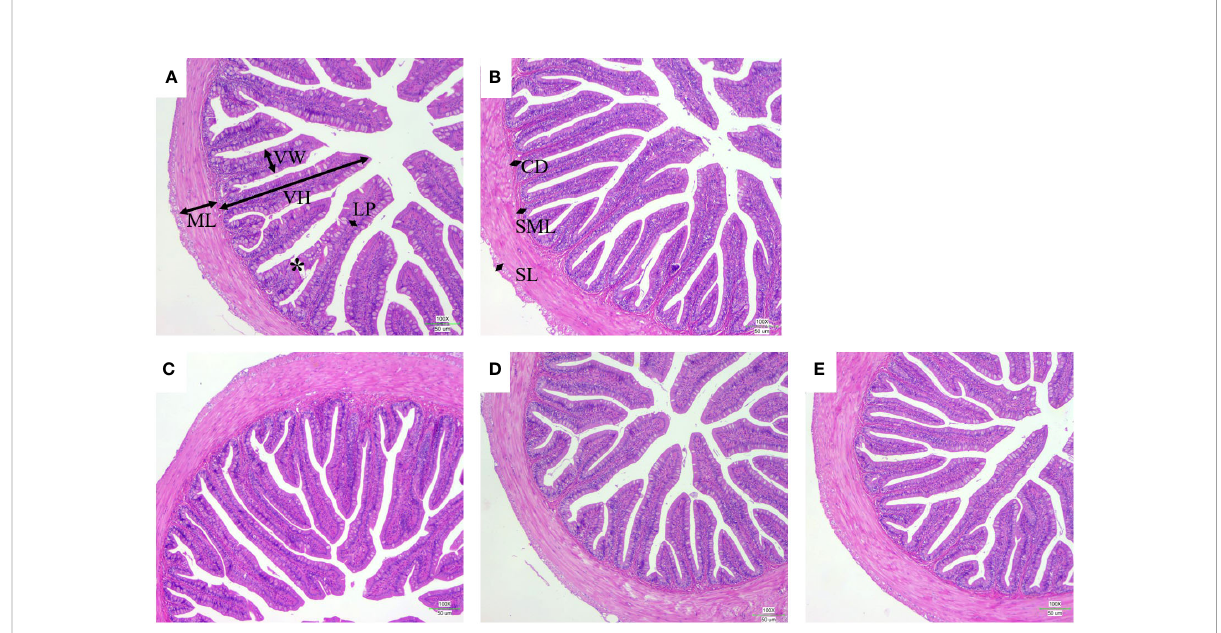
FIGURE 4 Effects of limonene, allicin and betaine on intestinal morphology of M. salmoides for 9 weeks. CD, crypt depth; LP, lamina propria; ML, muscular layer; SL, serous layer; SML, submucous layer; VH, villus height; VW, villus width. Scale bars = 50 m m. (A) FM30; (B) FM40; (C) FM30 + L; (D) FM30 + A; (E) FM30 + B.